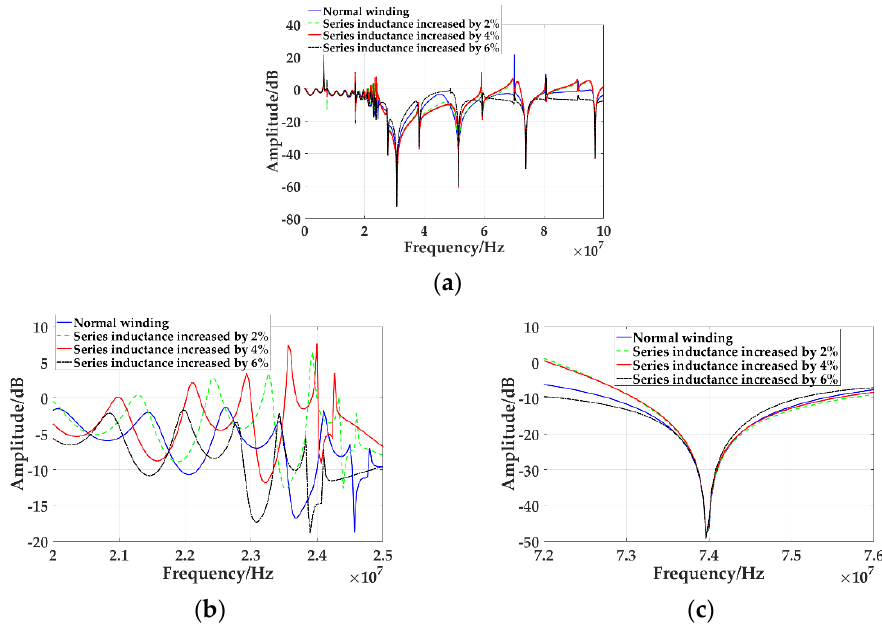
Figure 12. Frequency response curves of different degrees of radial deformation of winding: ( a ) Frequency response curve from 0 MHz to 100 MHz ; ( b ) Frequency response curve from 20 MHz to 25 MHz ; ( c ) Frequency response curve from 72 MHz to 76 MHz .